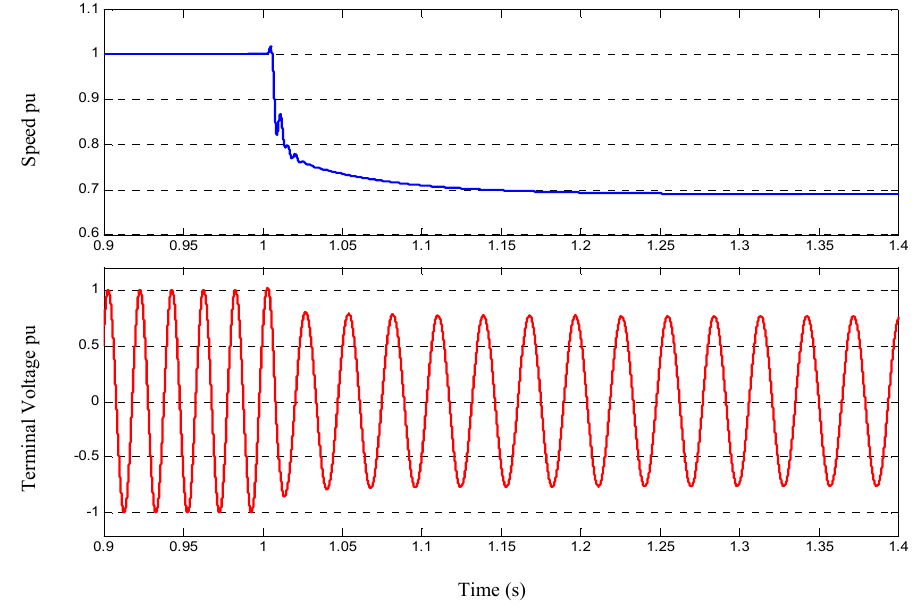
Figure 11. The machine islanded with 100% active and 100% reactive load.